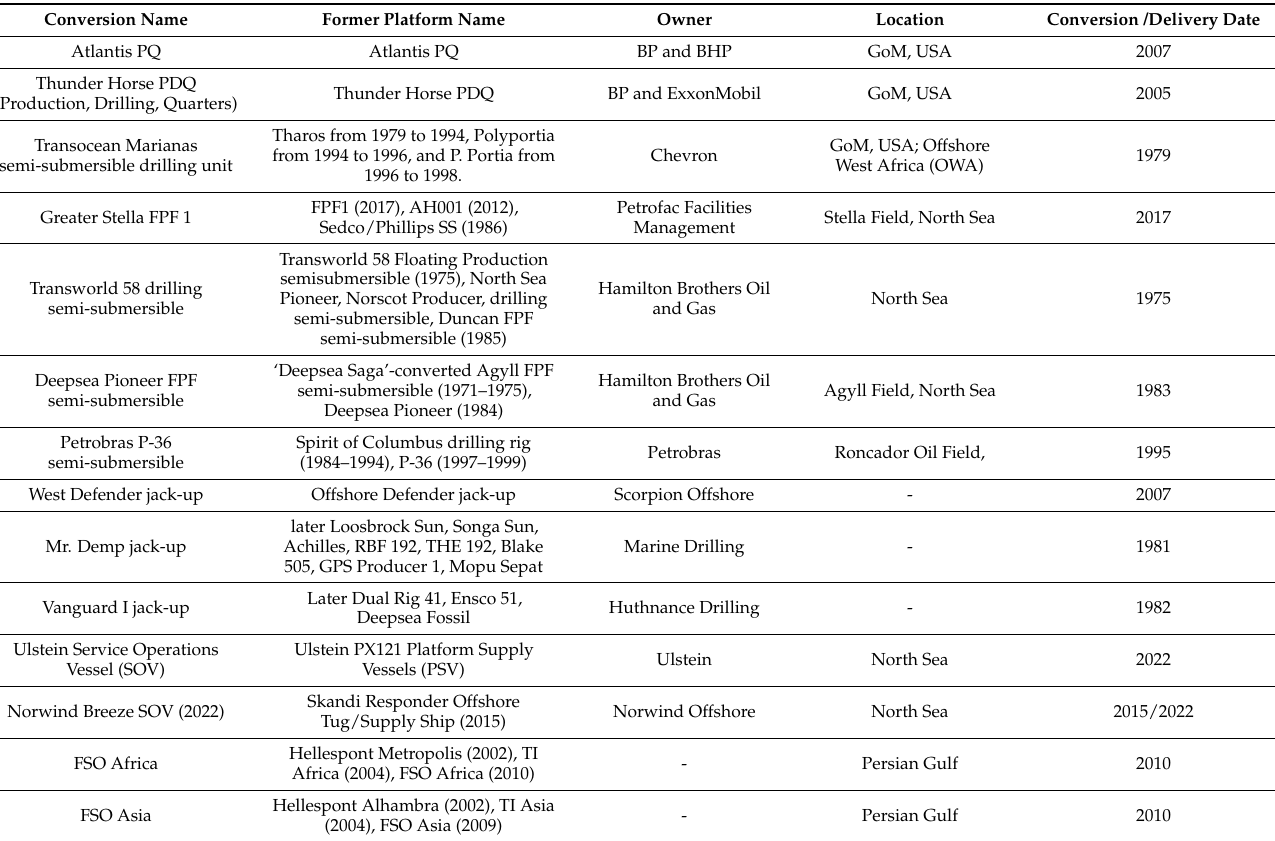
Table 14. List of some converted vessels and offshore platforms with conversion/delivery